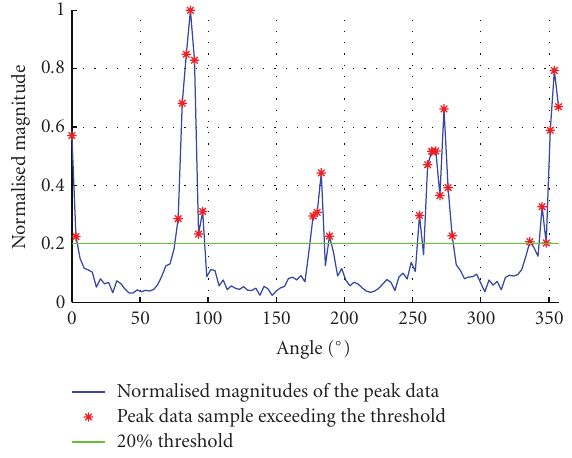
Figure 10: Normalized magnitudes of the peak data with marked samples exceeding a 20% threshold.